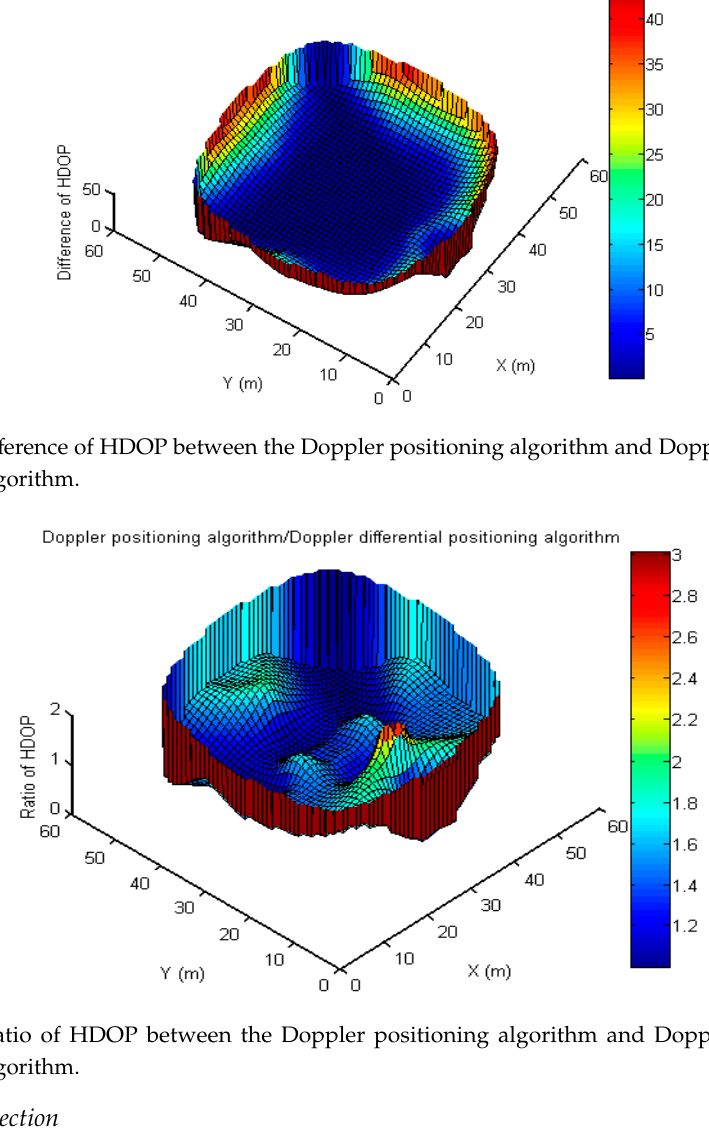
Figure 15. Ratio of HDOP between the Doppler positioning algorithm and Doppler differential positioning algorithm.